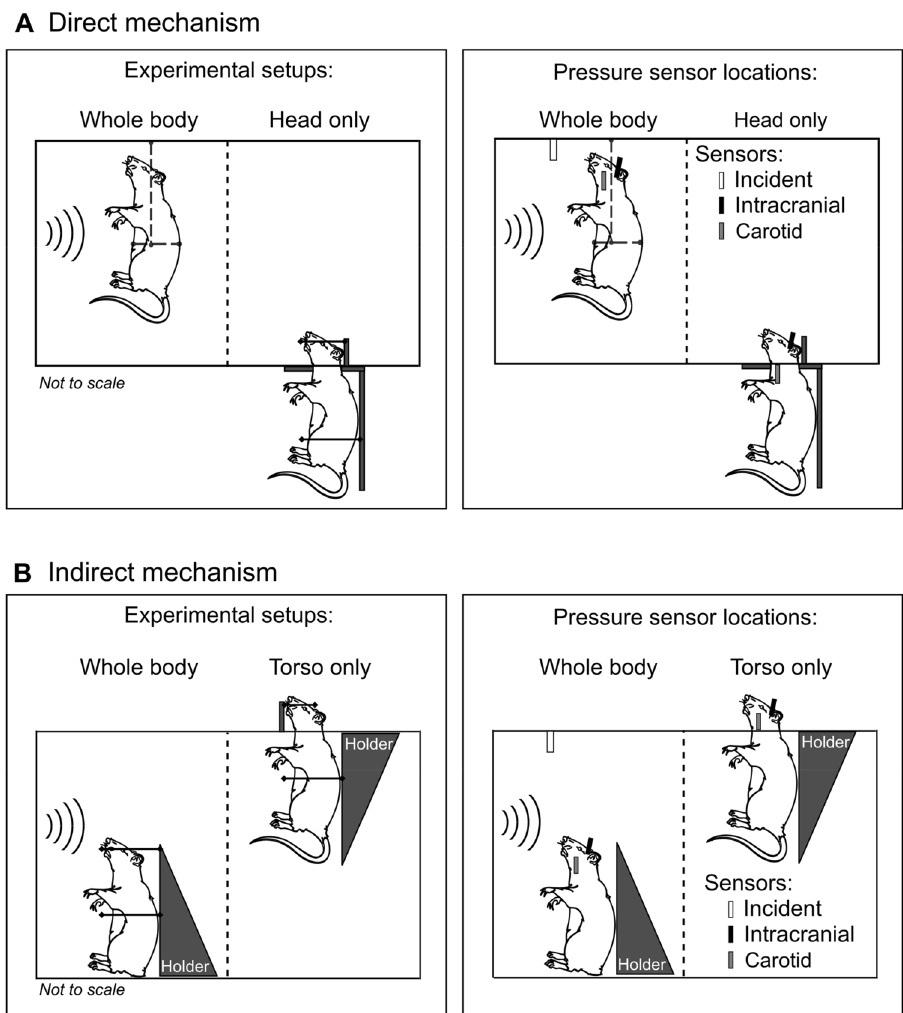
Figure 1. Shock-tube experiments to isolate two potential mechanisms of primary-blast injury. ( A ) We considered whole-body and head-only blast-exposure configurations to investigate the effects of the direct mechanism. In the whole-body configuration setup, we mounted the rat in a custom-made sling inside the test section of the shock tube. This setup minimally restrained the animal’s motion. In the head-only configuration setup, we isolated the torso of the rat from the blast exposure by securing it to a vertical cylinder outside of the shock tube and allowed the head to protrude into the test section through a small opening. Additionally, we used flexible strings wrapped around the head to keep it in a vertical position without restraining its motion. We measured the incident, intracranial, and carotid-artery pressures at the locations shown by the white, black, and gray vertical bars, respectively, in the schematic on the right (we omitted the restraining strings to better illustrate the locations of the sensors). ( B ) We considered whole-body and torso-only blast-exposure configurations to investigate the effects of the indirect mechanism. In the whole-body configuration setup, we mounted the rat in a holder inside the test section of the shock tube, and used a thin cotton cloth and Velcro straps to secure the animal and minimize its motion. In the torso-only configuration setup, we isolated the head of the rat from the blast exposure by keeping it outside of the shock tube and securing the torso to a holder inside the test section. We measured the incident, intracranial, and carotid-artery pressures at the locations shown in the schematic on the right (we omitted the restraining Velcro straps to better illustrate the locations of the